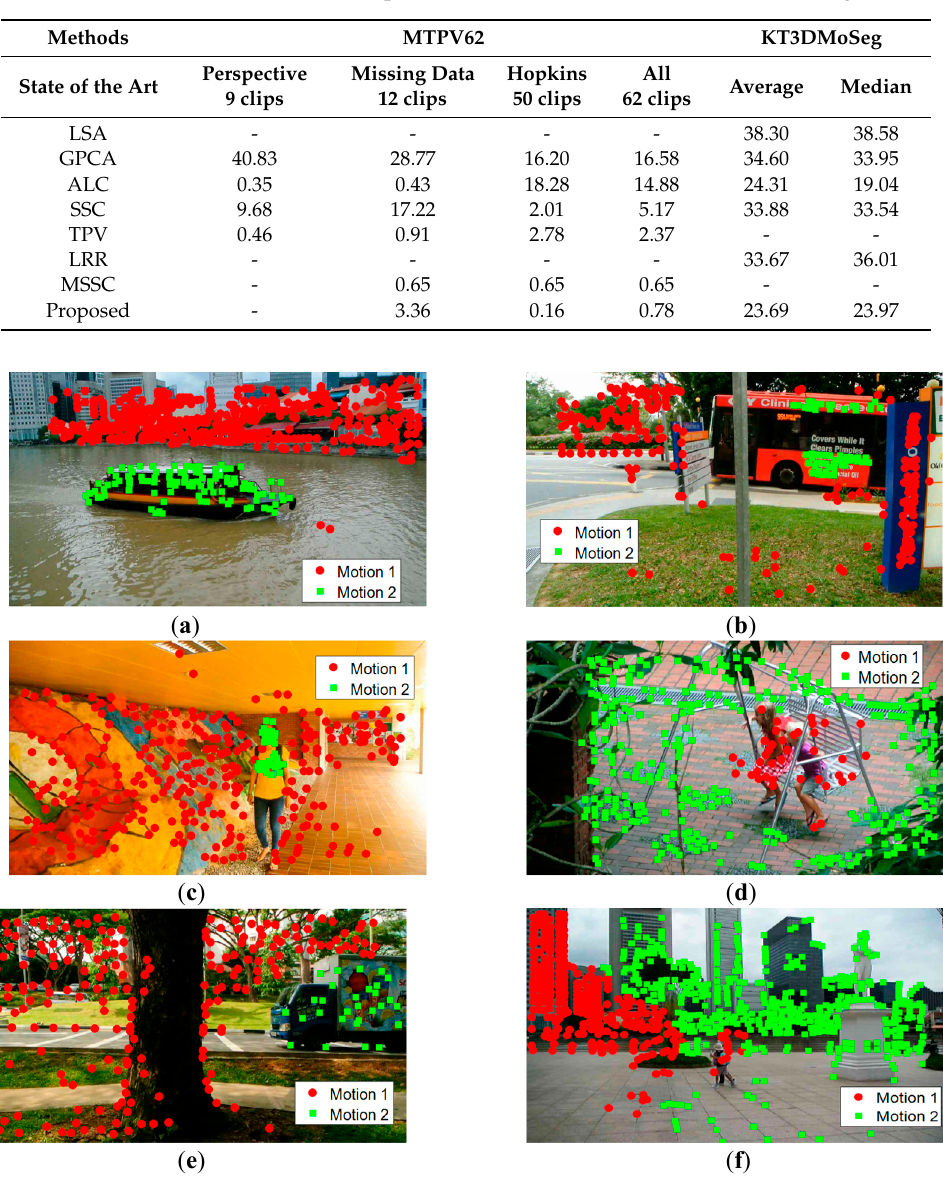
Figure 5. Sample results in video sequences of the MTPV62 dataset with the proposed method, with the different motions labeled with points of different colors and shapes. ( a ) Boat, ( b ) Bus, ( c ) Girl, ( d ) Swing, ( e ) Van, ( f ) Raffles.